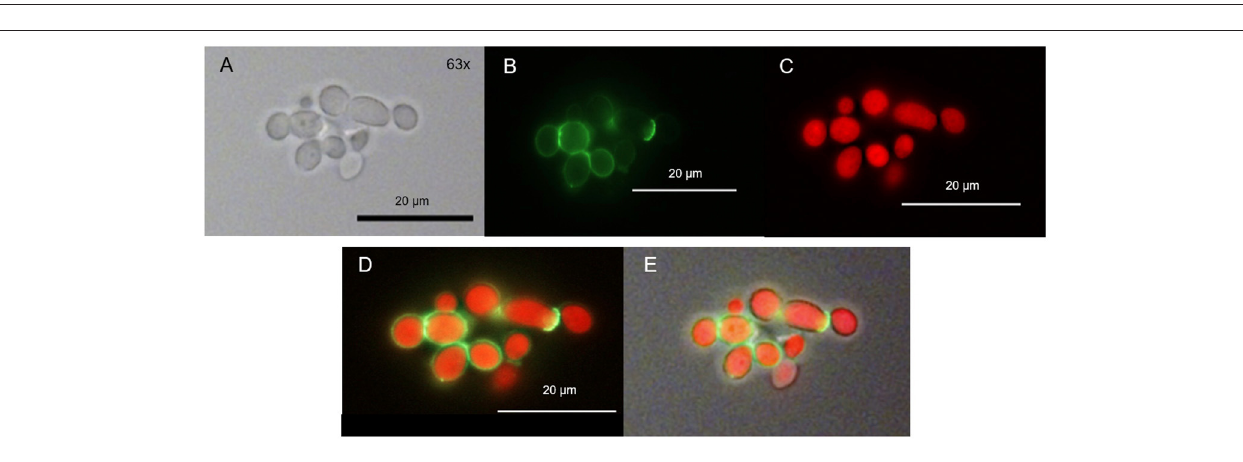
FIGURE 7 | Spatial distribution of TMPyP and WGA in C. albicans after irradiation. C. albicans was incubated with TMPyP (1 µ M) and WGA (50 µ g/ml) and irradiated with blue light (12 J/cm 2 ). With fluorescence microscopy WGA (green signal) accumulated in the area of the cell wall (B,D,E) . TMPyP-fluorescence (red signal) indicates homogenous distribution into the cytoplasm. C. albicans cells incubated with WGA and TMPyP imaged by brightfield microscopy (A) , fluorescence from WGA within the same cells ( B , filter: Oregon Green, fluorescence microscopy), fluorescence signals of TMPyP within the same cells ( C , filter: RedFP, fluorescence microscopy), overlay of both fluorescence signals (D) and overlay of the fluorescence signals and the brightfield micrograph (E)